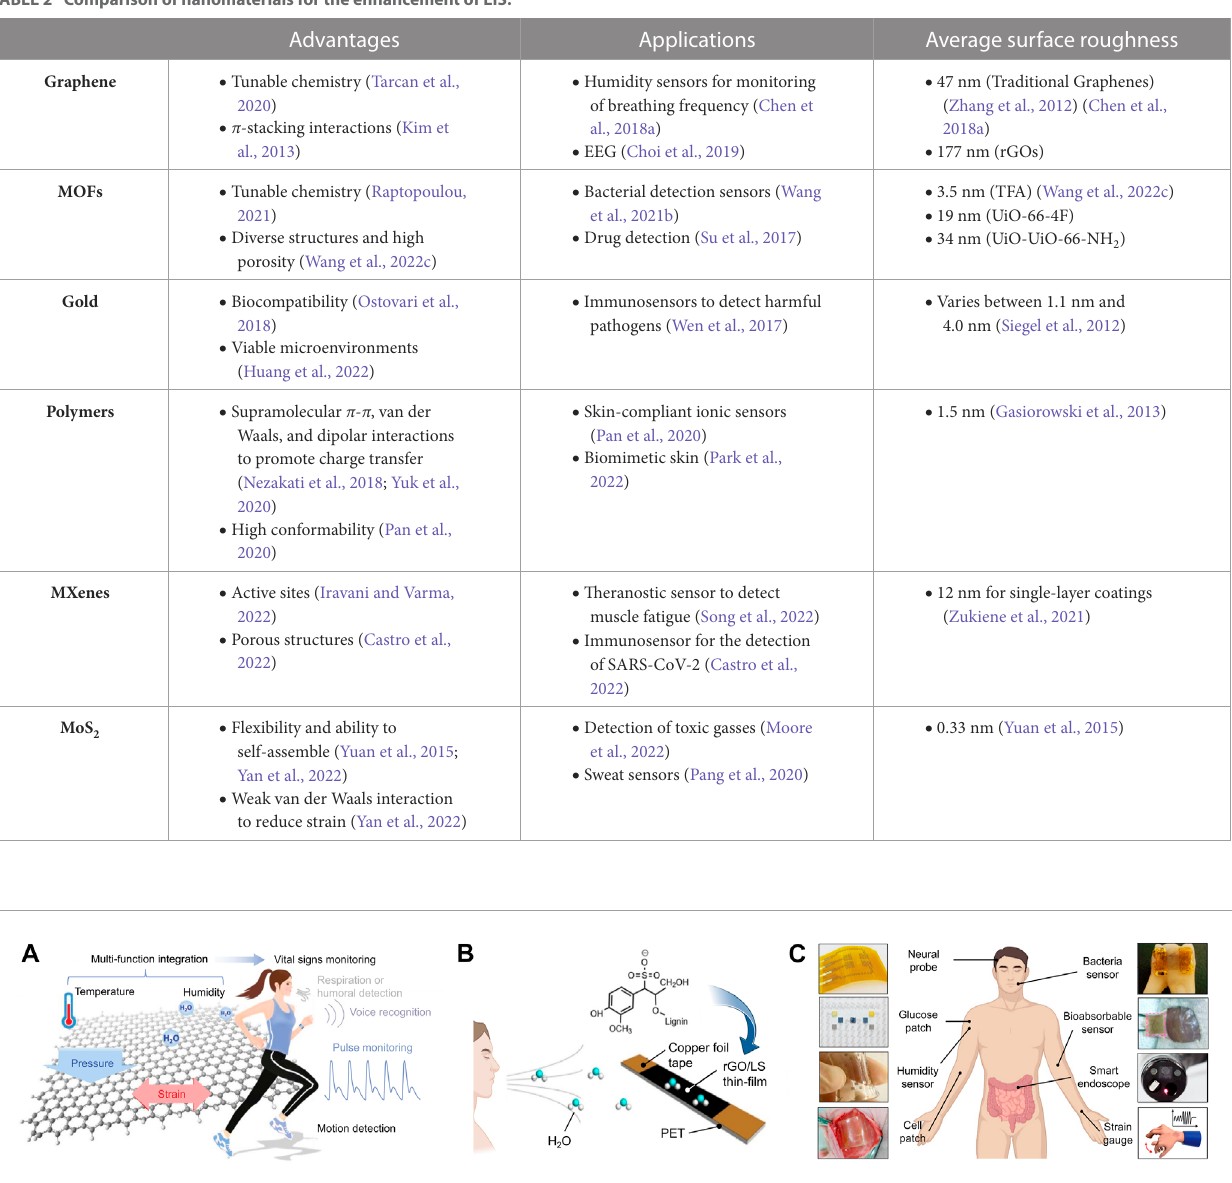
FIGURE 2 (A) Brief overview of a flexible graphene-based sensor platform. (B) A humidity sensor was fabricated based on an (LS)/rGO composite thin-film. (C) Wearable and implantable soft bioelectronics using 2D materials. [adapted and modified from (Choi et al., 2019; Yang et al.,